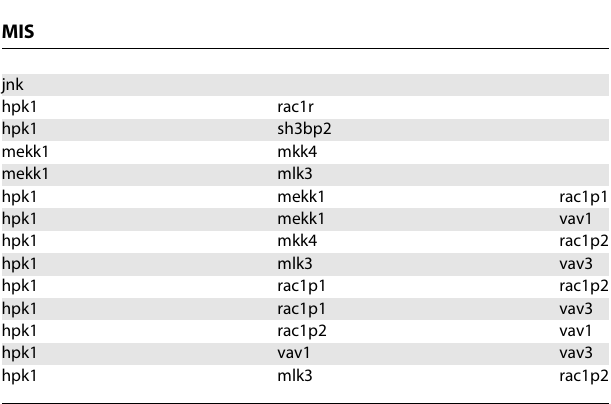
Table 2. Application of the Minimal Intervention Sets To Identify Candidates To Fill the Gap between PI3K and